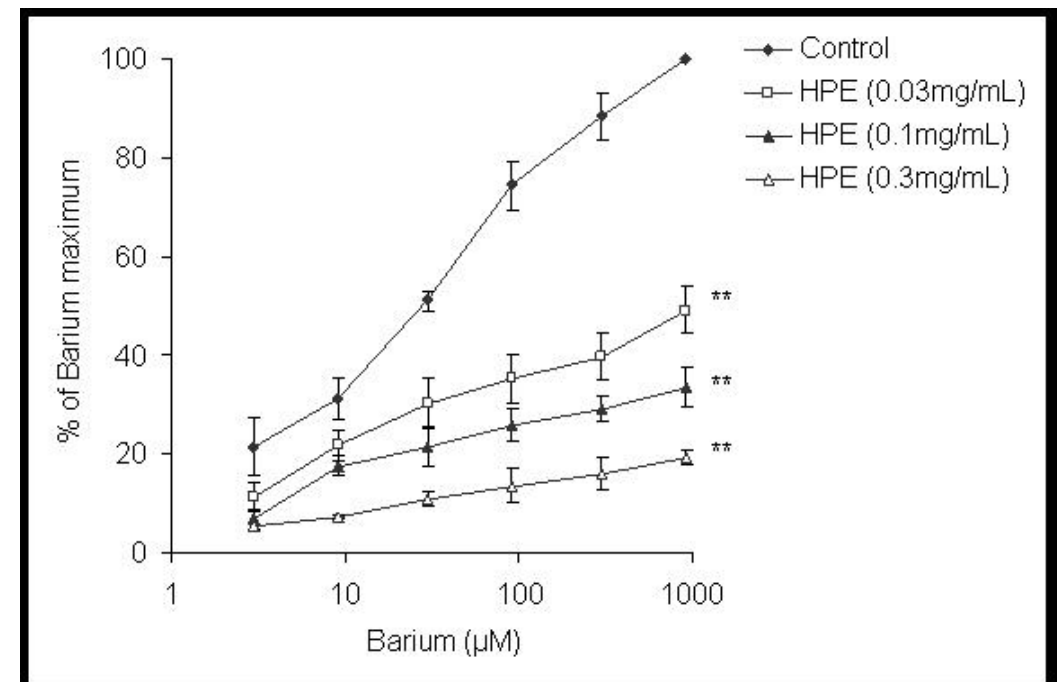
Figure 5. Comparison of dose-response curves of barium ions in absence and presence of Helichrysum plicatum extract (HPE) in isolated rat